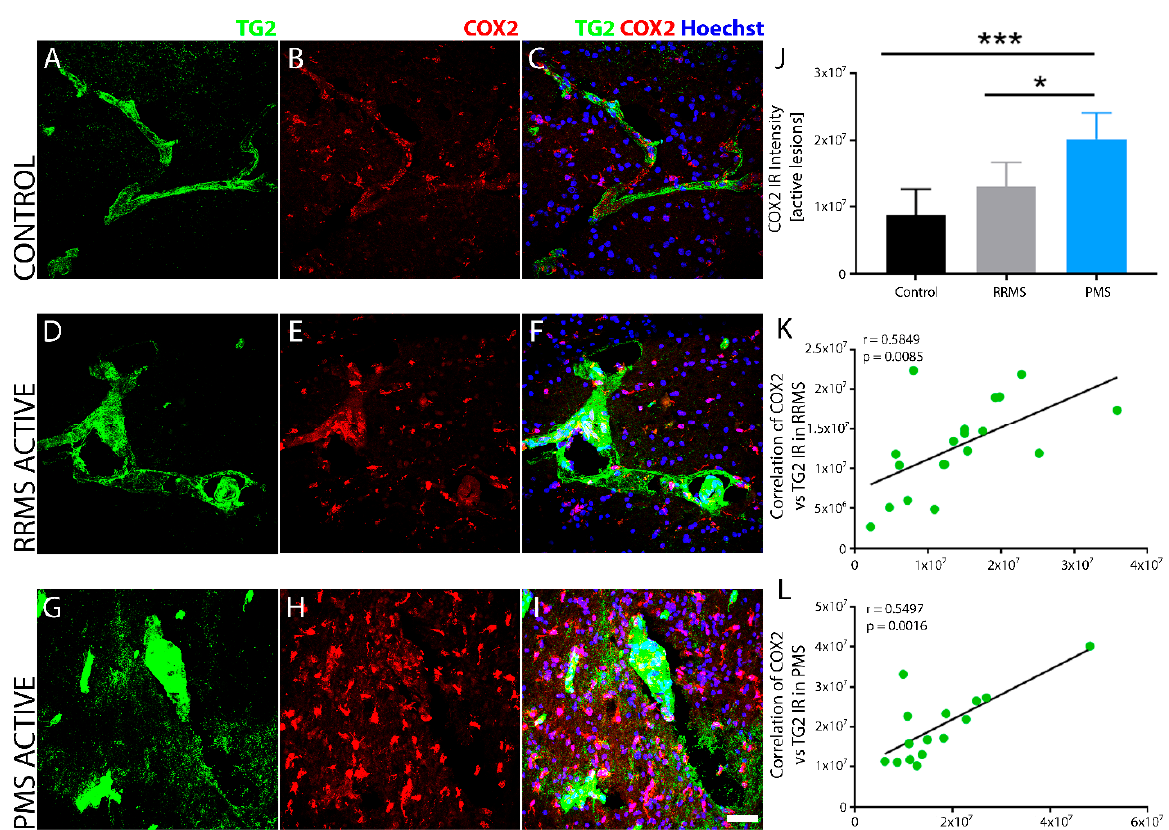
Figure 10. MS lesions show increased COX ‐ 2 immunoreactivity with TG2 in brain tissue after MS. Inducible COX ‐ 2 (red) levels were elevated in sclerotic lesions associated with TG2 (green) after MS. The non ‐ MS control brain tissue ( A ‐ C ) exhibited low, basal levels of COX ‐ 2 IR ( B , C ) compared to affected regions of brain tissue after RRMS ( D – F ), which showed a modest increase in COX ‐ 2 that was proportional to the level of the cellular density around the active lesion ( E,F ). Sclerotic lesions in PMS ( G – I ) exhibited a robust COX ‐ 2 expression ( H , I ) that was similarly localized but much higher in density ( H ). Quantitative assessment of COX ‐ 2 IR indicated significant upregulation only after PMS ( J ). Scale bar = 40 μ m. Data were quantified and expressed as value of the mean plus the standard deviation (SD). Statistical significance indicated a * p < 0.05, *** p < 0.0001 determined using